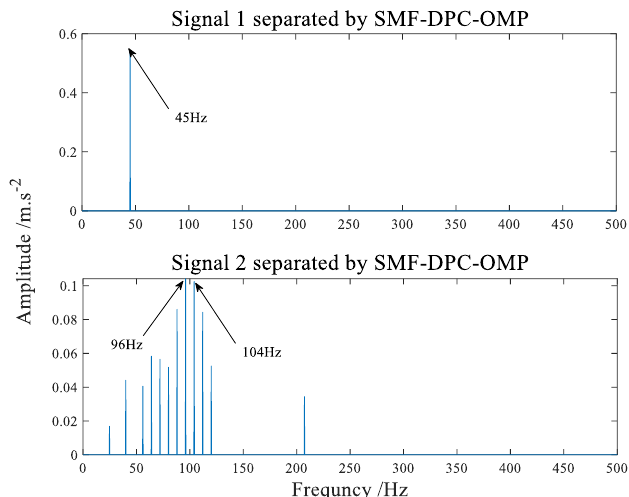
Figure 9. The amplitude spectrum of separated signal.